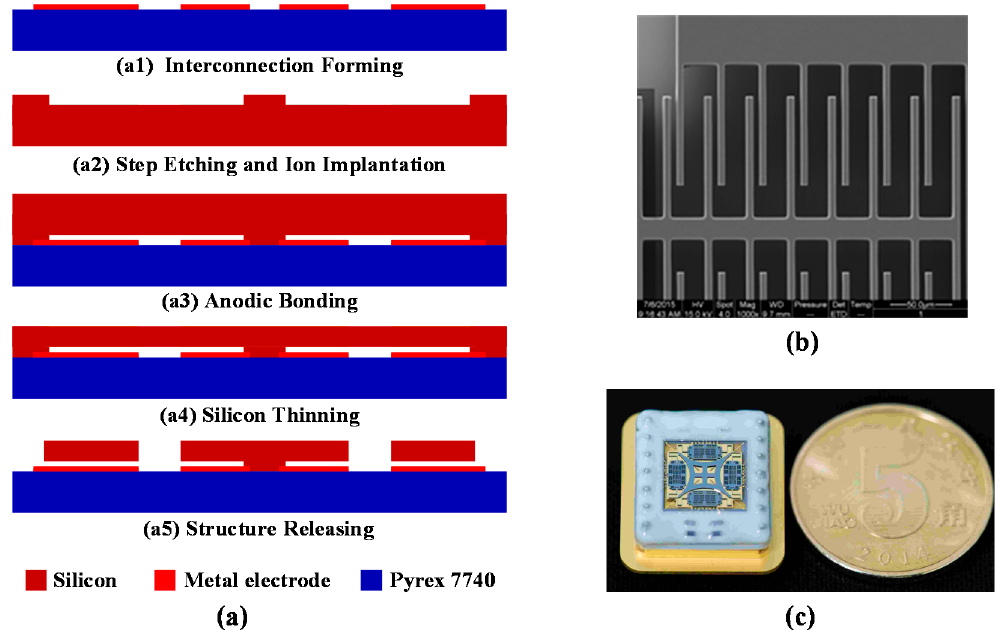
Figure 11. ( a ) Fabrication process of the CSQMG: ( a1 ) Interconnection forming; ( a2 ) Step etching and ion implantation; ( a3 ) Anodic bonding; ( a4 ) Silicon thining; ( a5 ) Structure releasing; ( b ) SEM of CSQMG force balance electrodes. The gaps between the adjacent comb fingers are 4 μ m and 16 μ m; ( c ) Photograph of the CSQMG die in a metal case ready for experimental